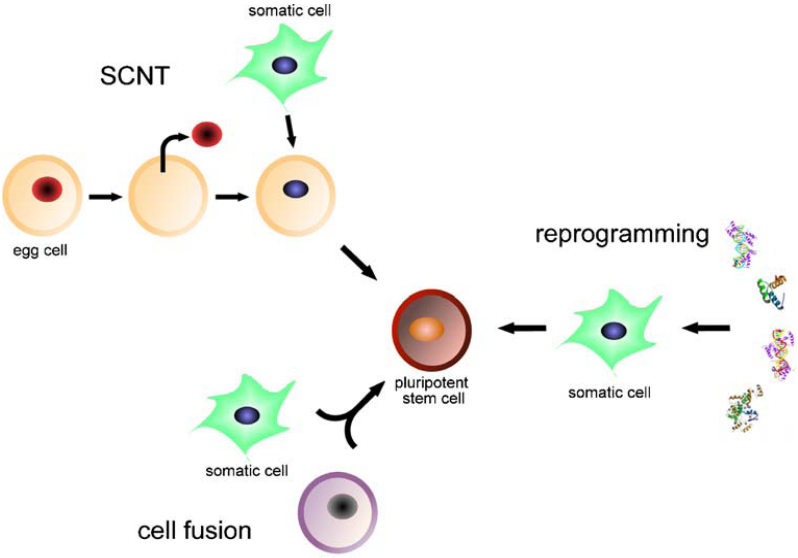
Figure 1. Methods of production of induced pluripotent stem cells. Reproduced from [10] with permission from